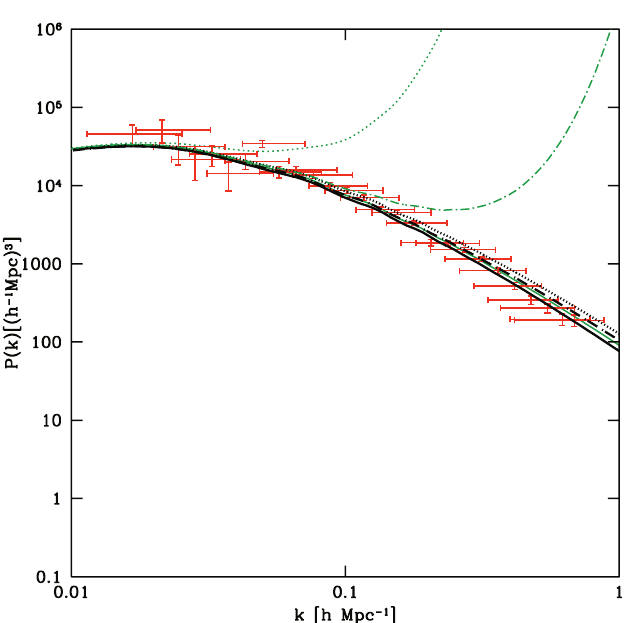
Fig. 3. UDM solution for perturbations as a function of the wavenumber k . The green dot, dot-dashed and solid curves are gCg models calculated by Sandvik et al. (2004), while the black curves are calculated in this paper with α = − 10 − 4 , − 10 − 5 and α = 0, respectively. The data points are the power spectrum of the 2df galaxy